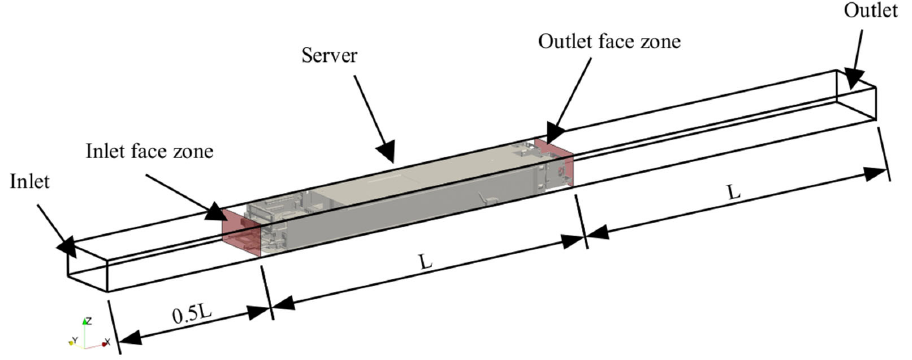
Figure 2. Computational domain and boundaries of the VWT.